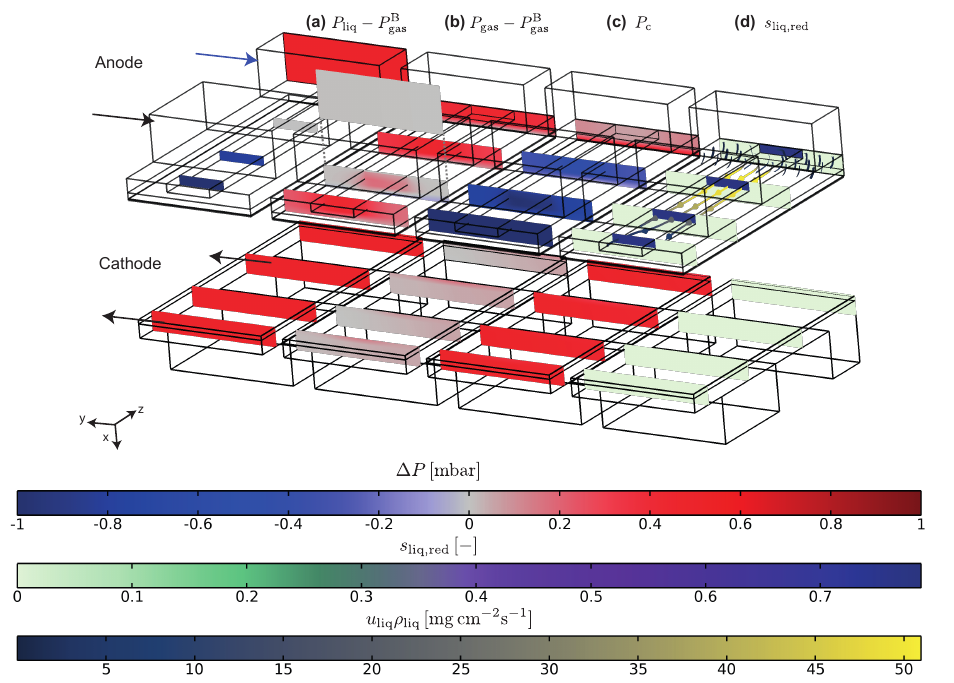
Figure 4. Base case model results: ( a ) liquid water pressure (difference to boundary gas pressure), ( b ) gas pressure (difference to boundary gas pressure), ( c ) capillary pressure, and ( d ) reduced liquid water saturation and liquid water flux streamlines, colored by flux magnitude. Anode and cathode are separated for